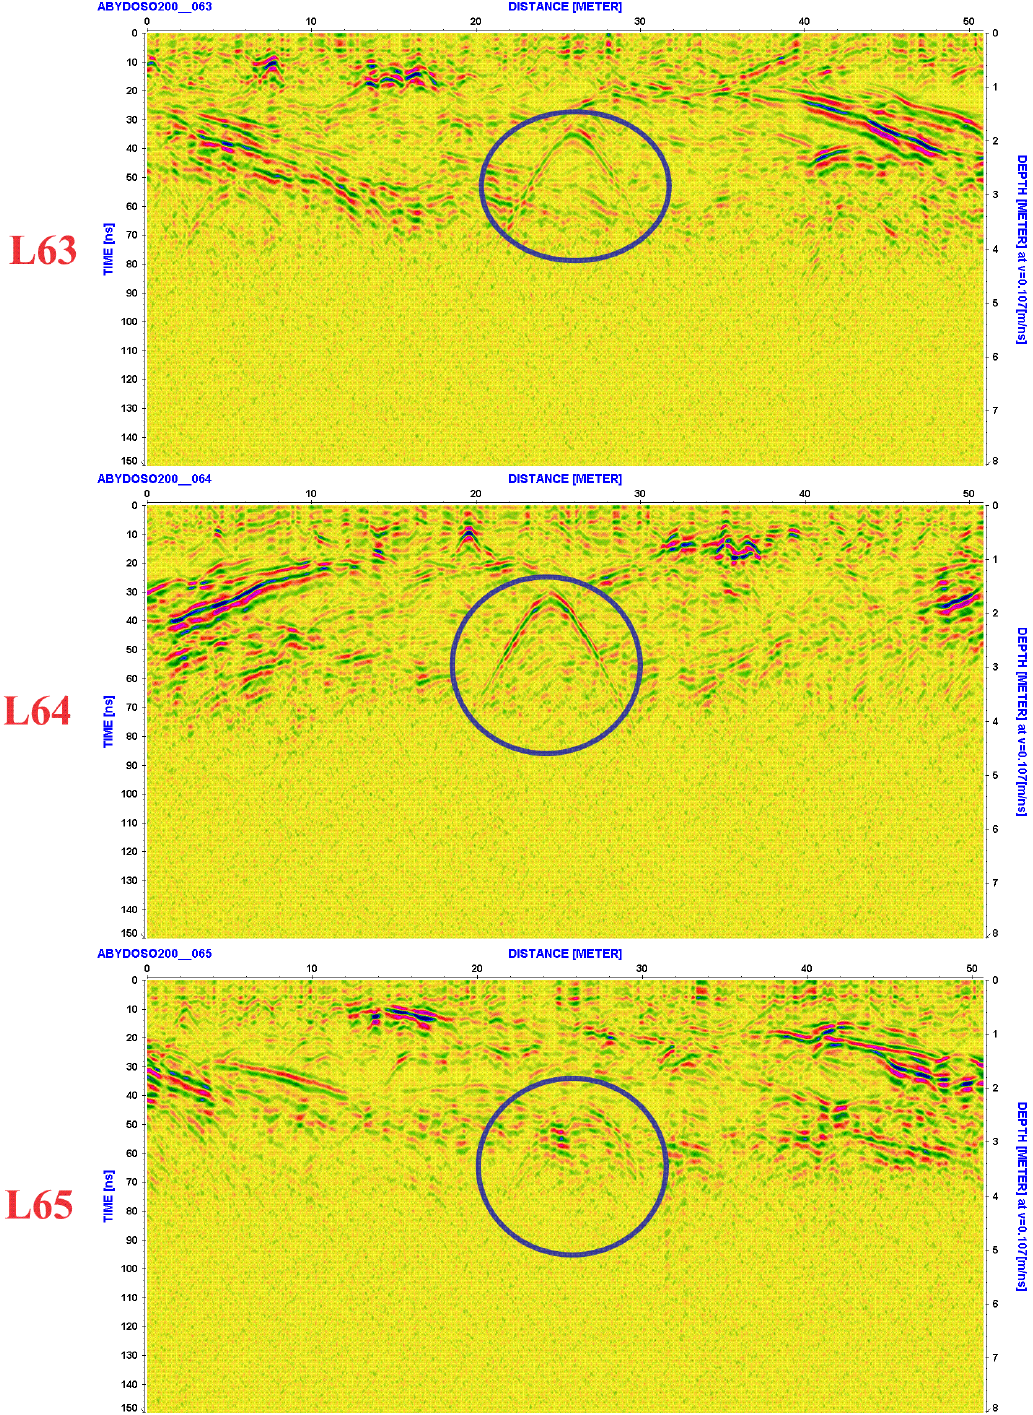
Figure 7. Radargram sections of three successive lines (L63, L64 and L65) executed on grid No. (3) during reconnaissance survey in Abydos site. Their lengths are 50 m. These sections show presence of the same anomalous feature indicated by the hyperbolic shape mentioned in the blue circle with considerable dimension and amplitude which may indicate an archeological remain (chamber or tomb).